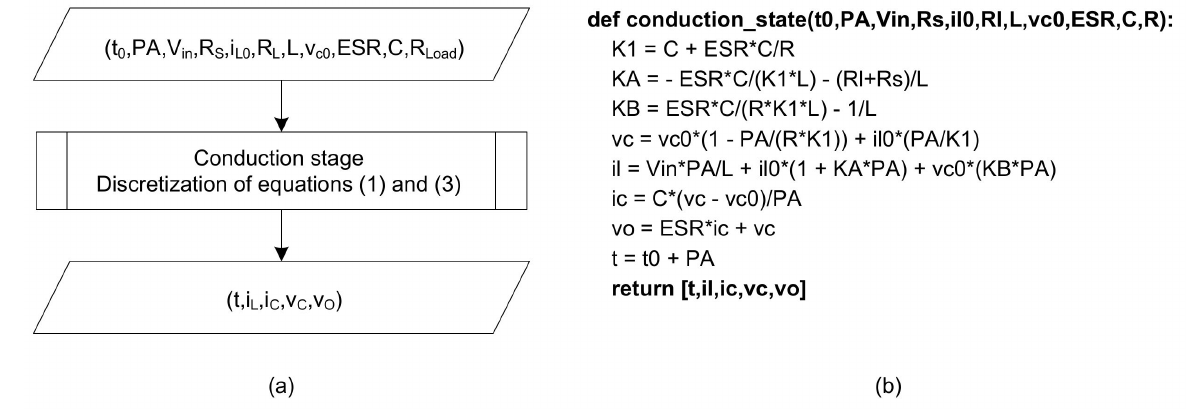
Figure 4. Function that models the behavior of the converter during the on state: ( a ) Algorithm and ( b ) Python code.